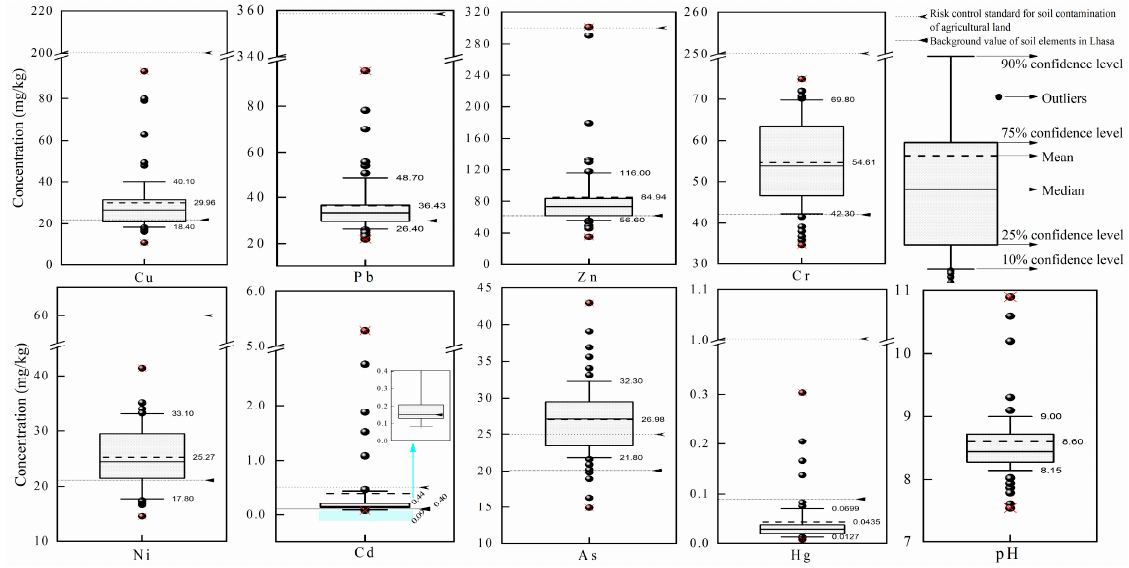
Figure 2. The soil heavy metal concentration characteristics. × : represents maximum and minimum values of soil heavy metal concentrations.